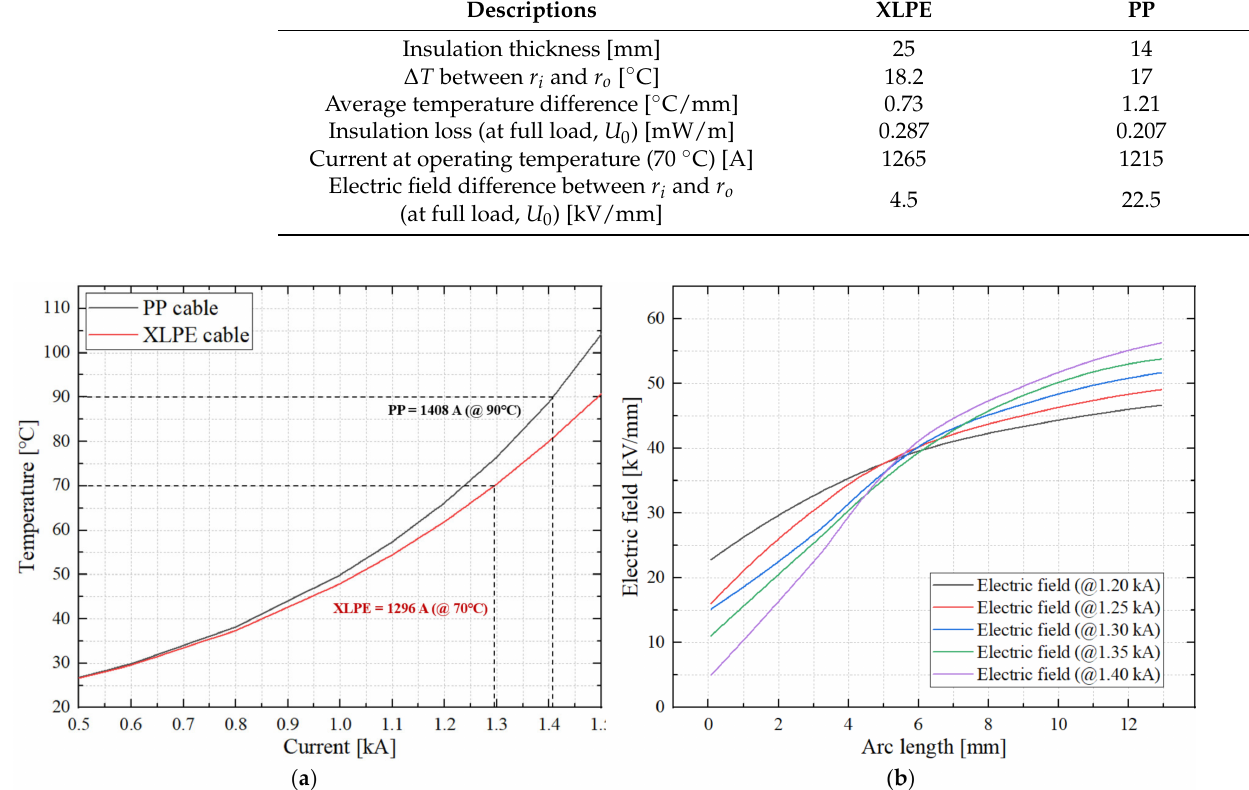
Table 4. Comparative analysis of cable insulations.